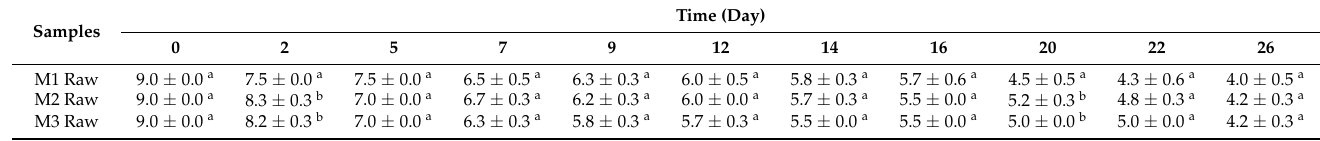
Table 4. Overall quality of raw fish burgers during storage at 4 ◦ C.